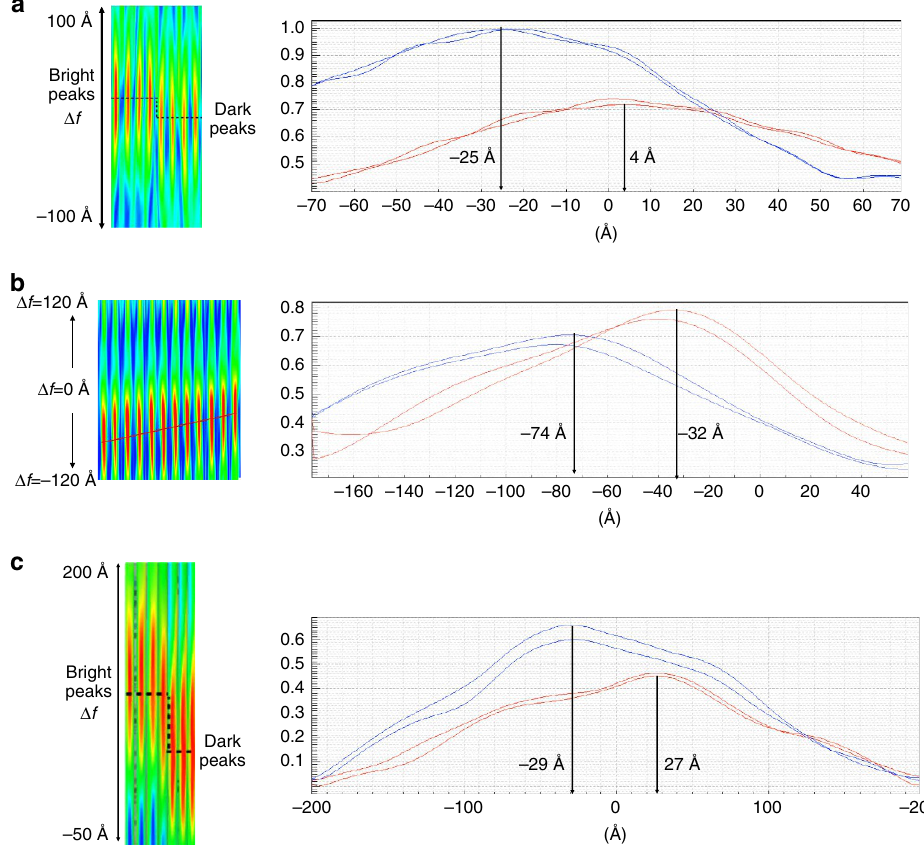
Figure 7 | Intensity of the column wave as function of the defocussing distance. ( a ) Cross-section of propagated intensity (ellipsoid shape, left of panel) and intensity profiles (right of panel) from dark (blue) and bright (red) columns of modulus of Ge exit wave (Fig. 2a). ( b ) Cross-section of propagated intensity (ellipsoid shape) and intensity profiles from the centre (blue dot) to the edge (red dot) columns of the modulus of Au exit wave (Fig. 2b). ( c ) Cross-section of propagated intensity (ellipsoid shape) and intensity profiles from dark (blue) and bright (red) columns of modulus of MgO exit wave (Fig. 2c). In three cases, two columns at two different positions are analysed. The position of the atom locates at the maximum (indicated), which can be determined with a precision of the order of